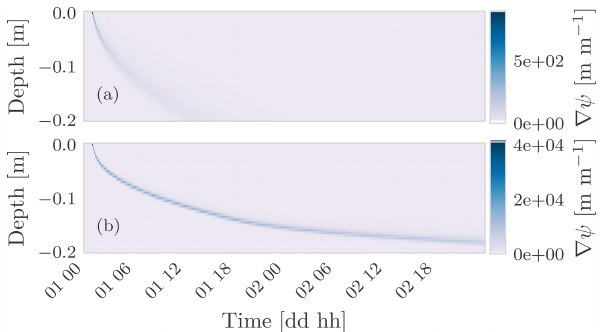
Figure C9. (a) The capillary gradient for the case of wet soil and (b) the capillary gradient for the case of dry soil. As can be seen, in the dry soil the capillary gradient is 2 orders of magnitude larger than in the wet soil. Because of this higher gradient water infiltrates faster in the dry soil than in the wet soil.